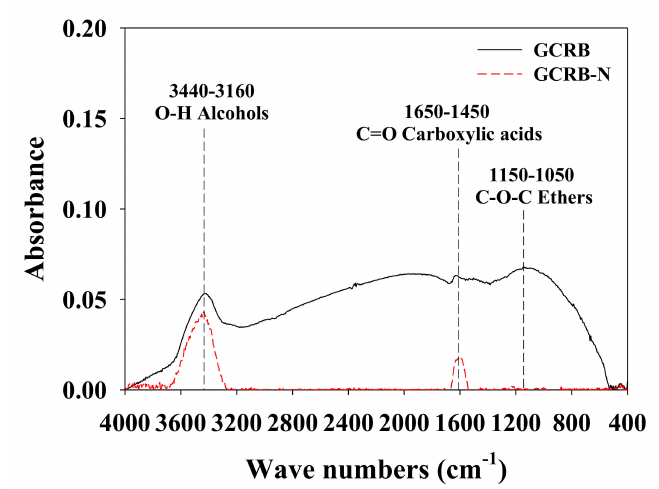
Figure 3. The FT-IR spectra of the GCRB and GCRB-N.